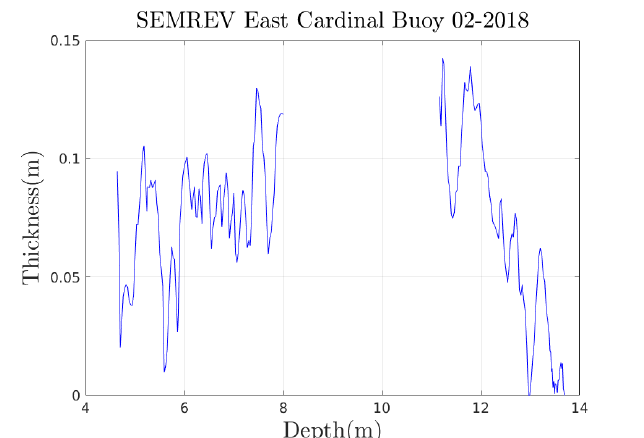
Figure 5. Trajectory of the bio-colonisation thickness on East cardinal buoy mooring chain in February